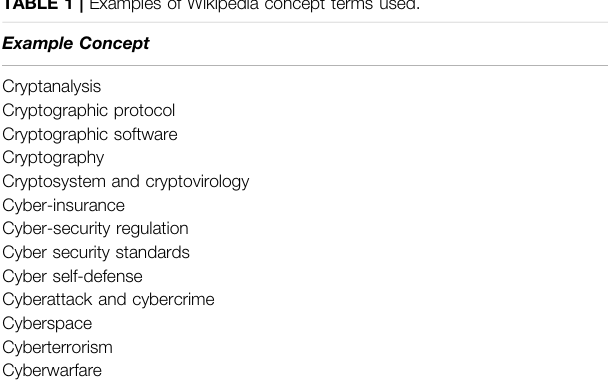
TABLE 1 | Examples of Wikipedia concept terms